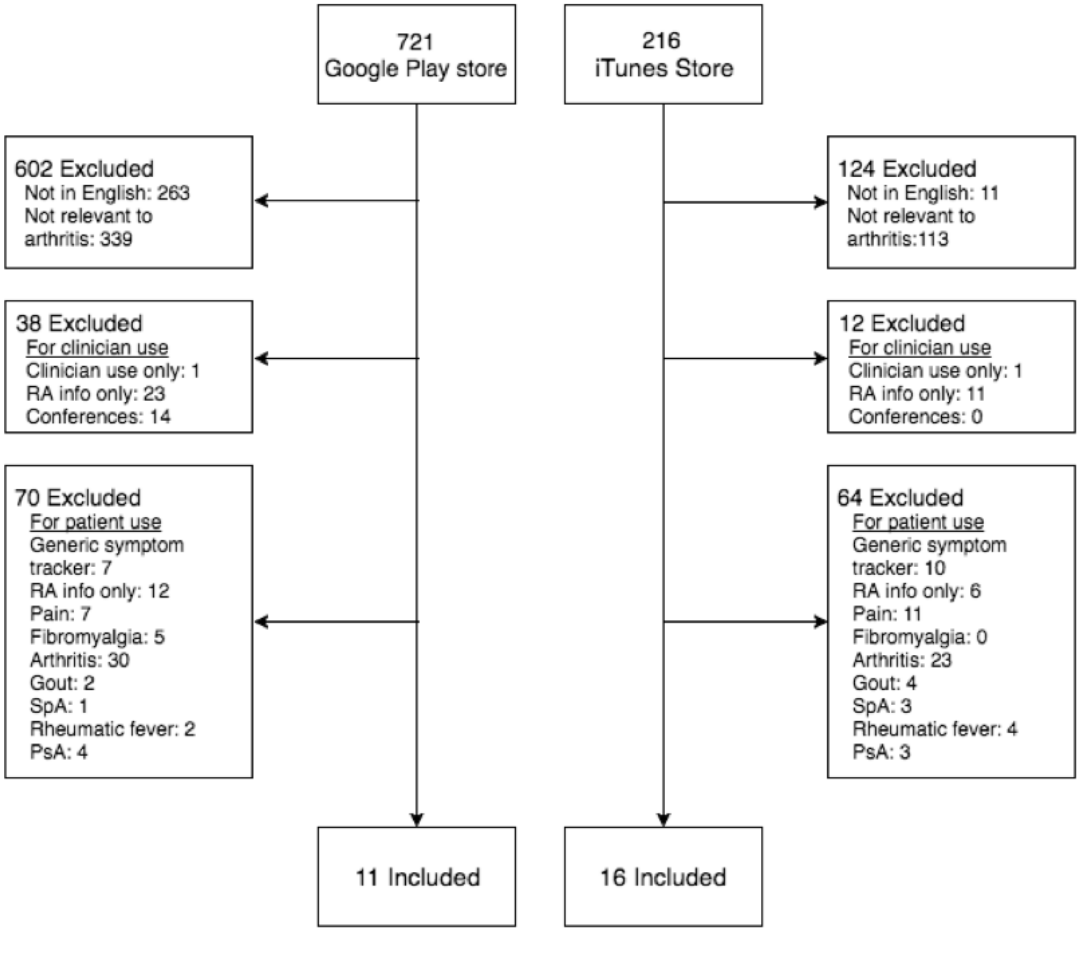
Figure 1. Flow diagram of systematic search and selection of app from Google Play and iTunes